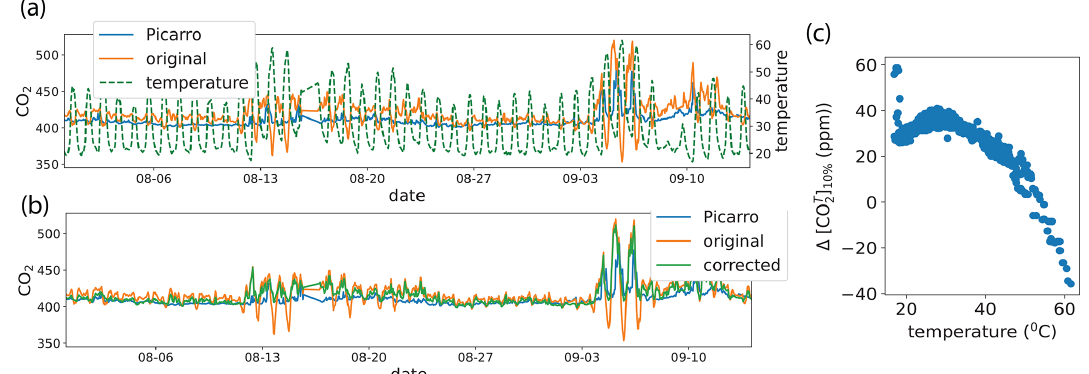
Figure 4. (a) CO 2 mixing ratios measured by the Picarro instrument at the Richmond Field Station (blue solid), uncorrected CO 2 measured at Elsa Widenmann Elementary School (orange solid), and node temperature measured at Elsa (green dashed). (b) CO 2 mixing ratios at Elsa Widenmann Elementary School with no temperature correction (green), temperature correction applied (green) and measured with a Picarro instrument at the Richmond Field Station (blue). (c) Temperature dependence at Elsa Widenmann Elementary School of (cid:49) [ CO 2 ] T